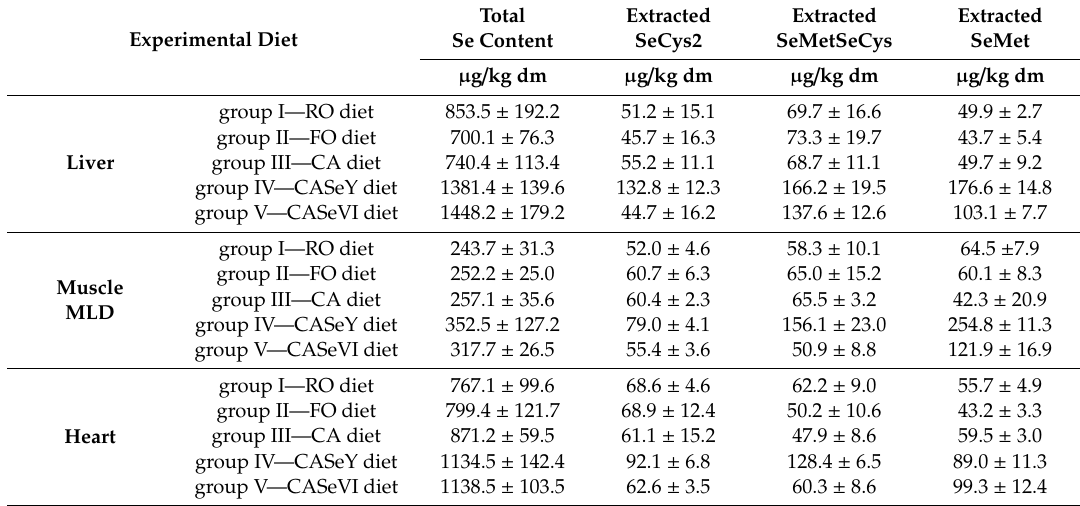
Table 3. Quantification of total Se content and the selenium species in lamb tissue (results expressed per dry mass